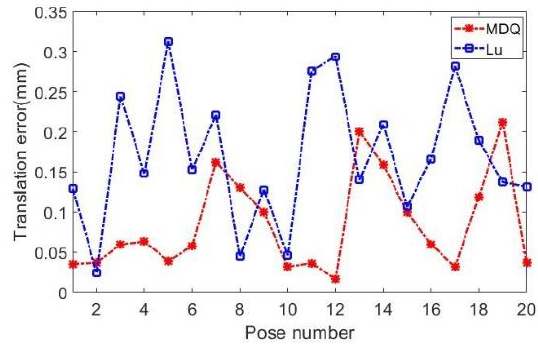
Figure 2. The RMS errors in translation without noise interference.